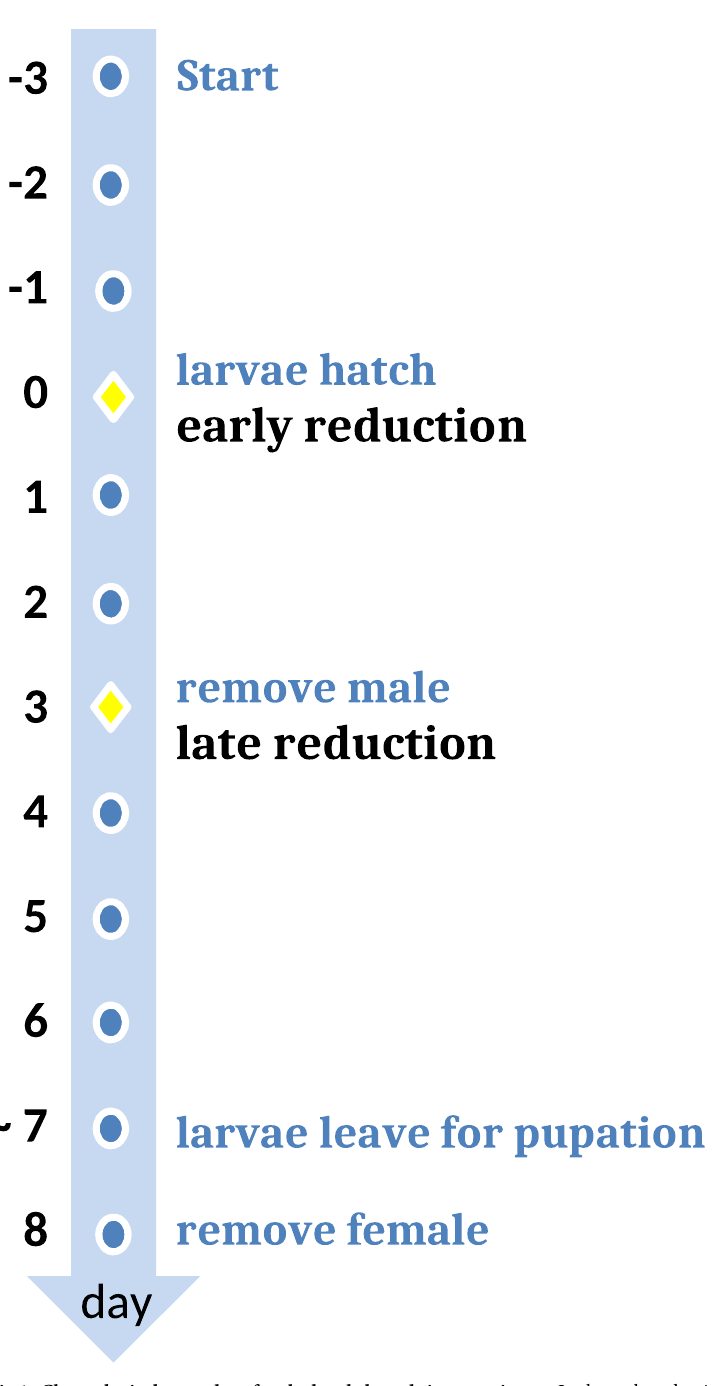
Fig 1. Chronological procedure for the beetle brood size experiment. In the early reduction treatment, we started larval regulation directly after the first larvae appeared on the carcass. Brood size in the late reduction treatment was reduced three days